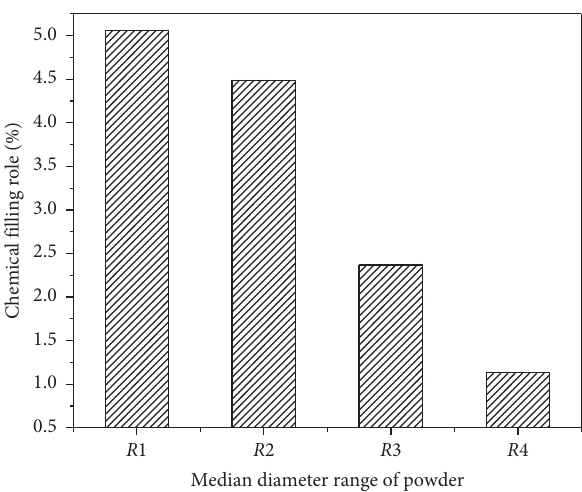
Figure 13: Chemical filling role of steel slag powder with different particle sizes in blended cement